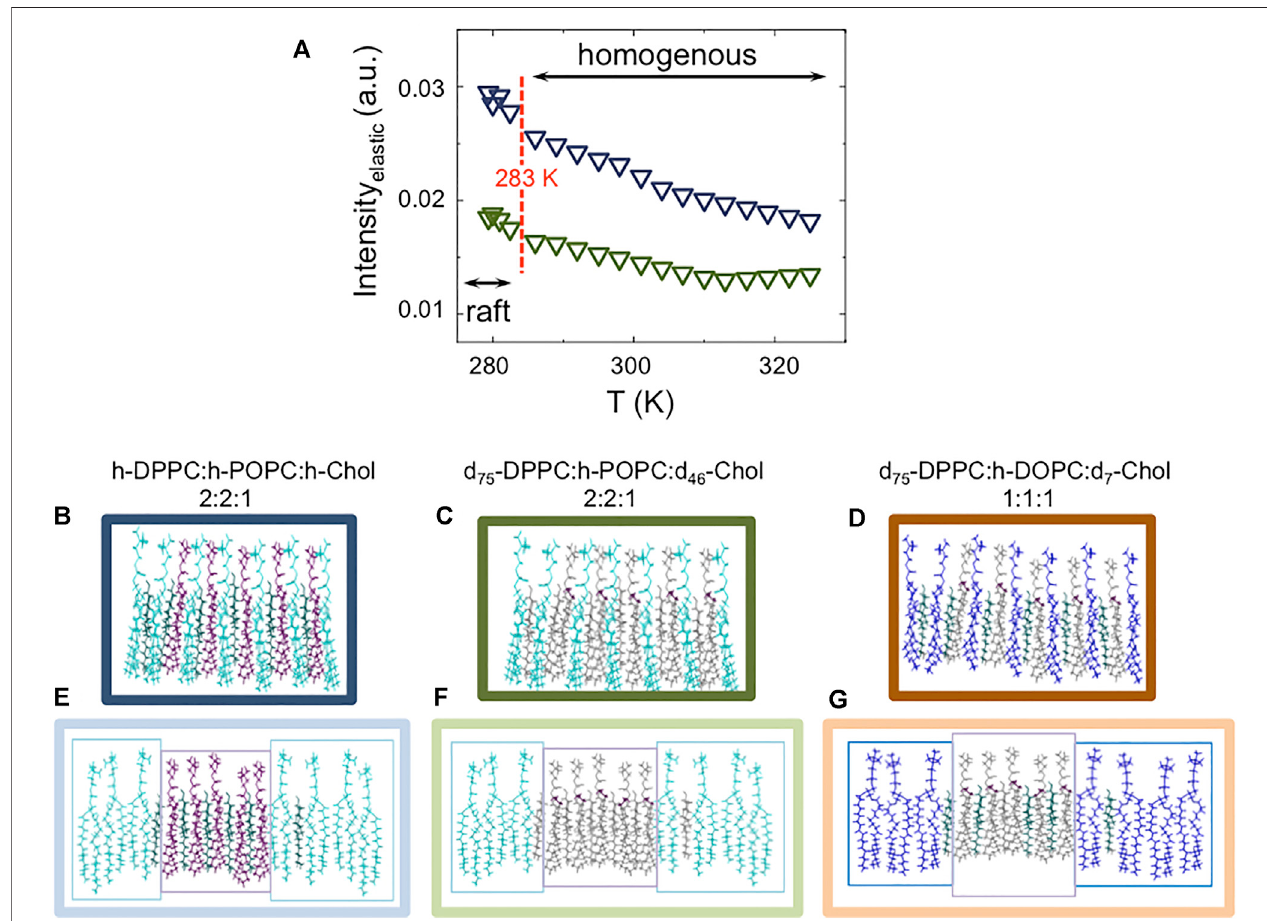
FIGURE2|(A) Elastic fi xedwindowscan(EFWS)forfullyprotiatedDPPC:POPC:Chol(molarratio2:2:1)(bluetriangles)anditspartiallydeuteratedanalogue(green triangles; d 75 -DPPC: h -POPC: d 46 - Chol). (B – G) Cartoons depict the phase separation at the two extreme temperatures [323, (B – D) , and 283 ± 0.1 K; (E – G) ] for fully protiated and partially deuterated DPPC:POPC:Cho l 2:2:1 (blue and green, respectively) as well as for d 75 -DPPC :h -DOPC :d 7 -Chol 1:1:1 (brown). Lipid raft cartoons were made using VMD package